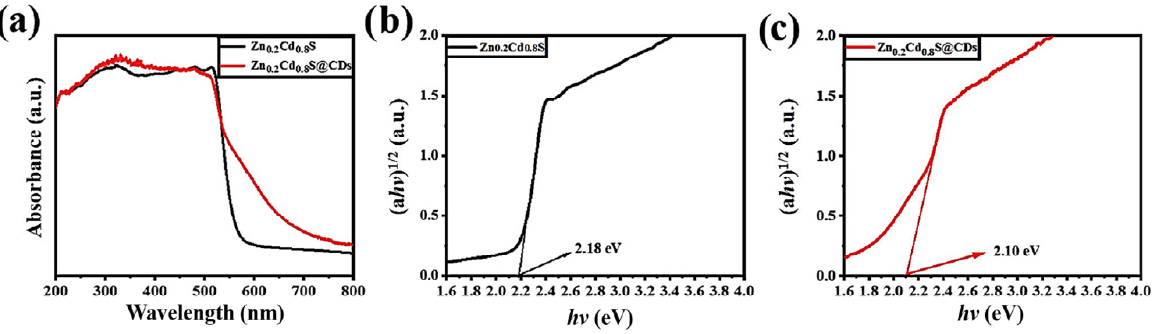
Figure 4. ( a ) UV-Vis DRS absorption spectra of Zn 0.2 Cd 0.8 S and Zn 0.2 Cd 0.8 S@CDs; Band gap energy of ( b ) Zn 0.2 Cd 0.8 S and ( c ) Zn 0.2 Cd 0.8 S@ CDs.